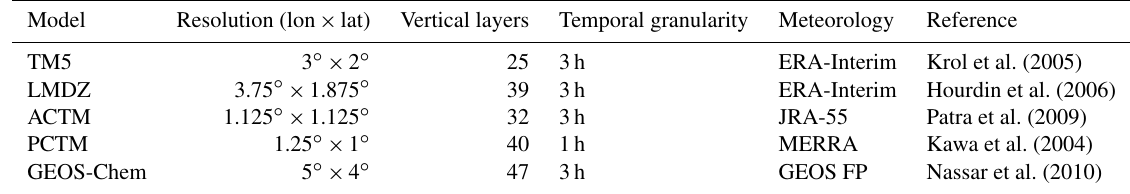
Table 1. The different atmospheric transport models run in this study to produce CO 2 fields. Model